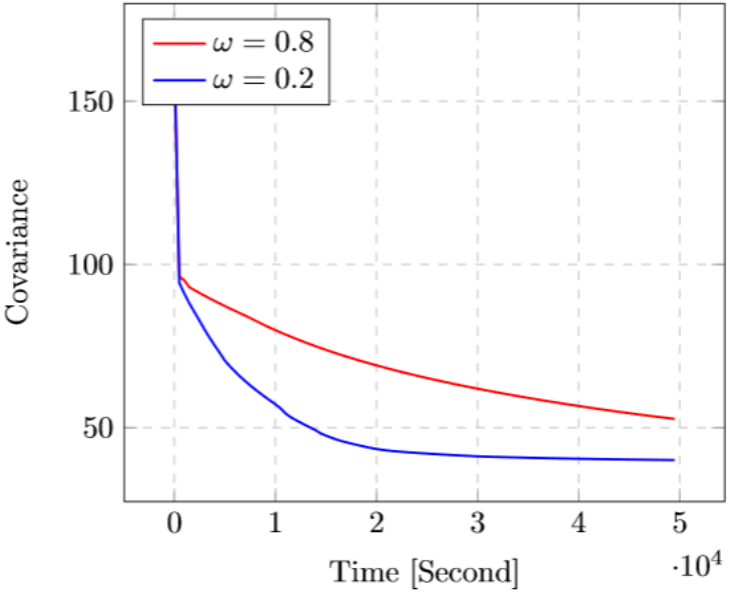
Figure A4. Covariance for an alternative environment, namely with ω = 0.8 and ω = 0.2 and 20